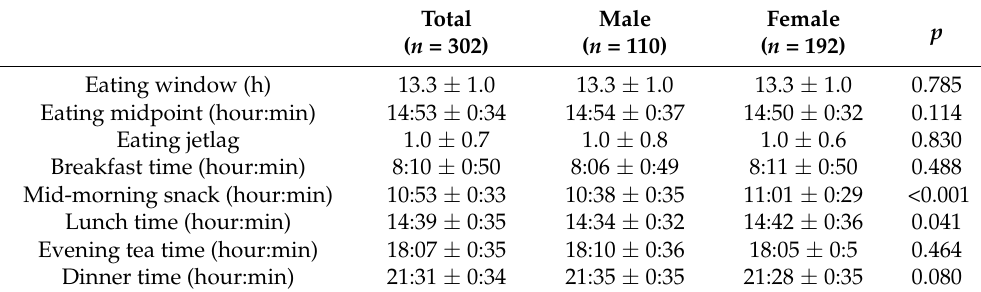
Table 3. Descriptive characteristics of the eating patterns in the whole sample and those per